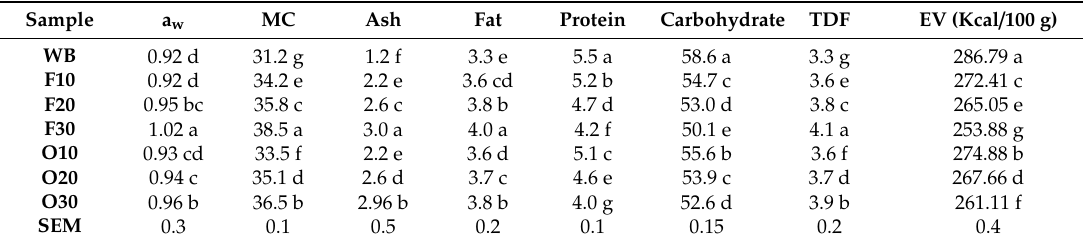
Table 1. Chemical composition properties of bread samples per 100 g (wet